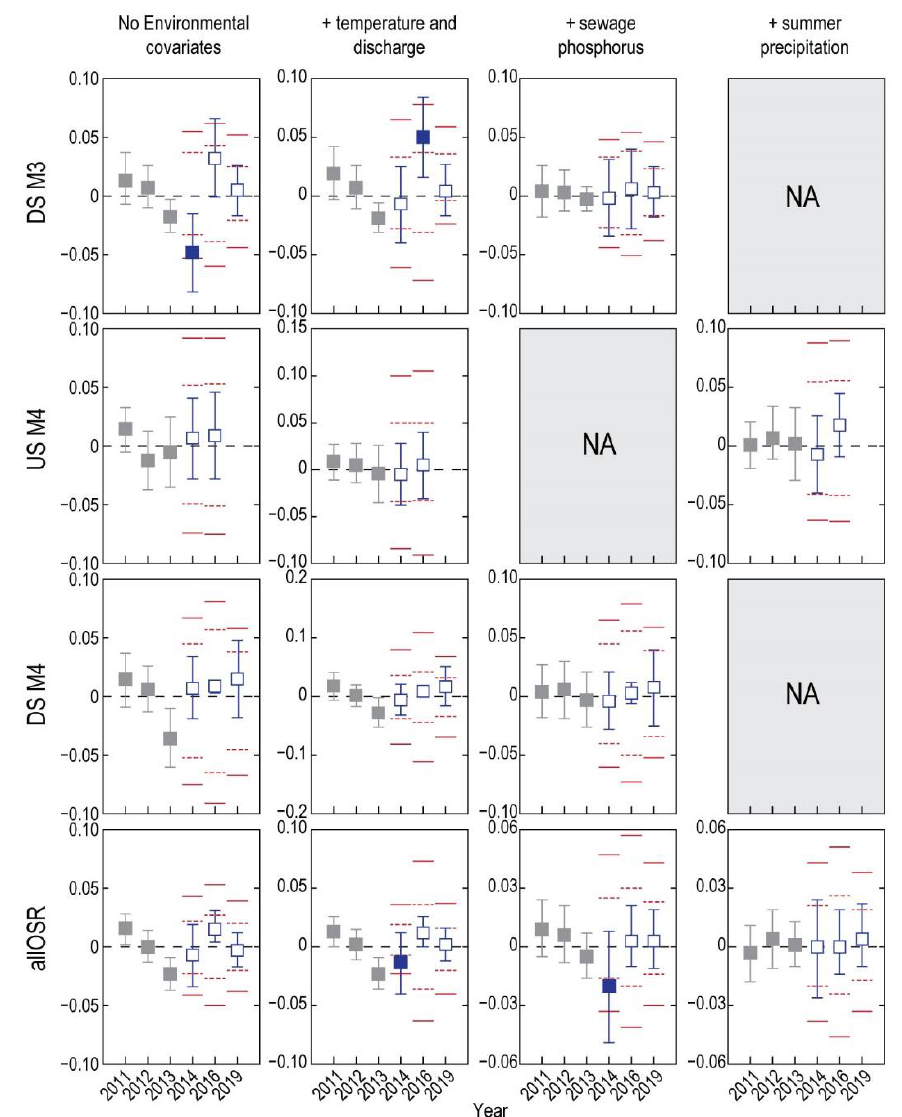
Figure 4. Median residual body weight (BW) of female white sucker (±log10; g) from site-specific regressions done without environmental covariates, with T and D, with T, D, and P, and either T, D, P, and Pr, or T, D, and Pr; “NA” indicates a non-applicable analysis; upper and lower dashed horizontal red lines denote 97.5 and 2.5 percentiles, respectively; upper and lower solid horizontal dashed lines denote outer tolerance limits for the 97.5 and 2.5 percentiles, respectively; error bars in observed test and reference data show 95% confidence intervals; solid symbols suggest a potentially relevant difference; open symbols show potentially irrelevant differences; solid grey symbols denote baseline years (2011–2013) used to derive thresholds used for test years (2014, 2016, 2019).